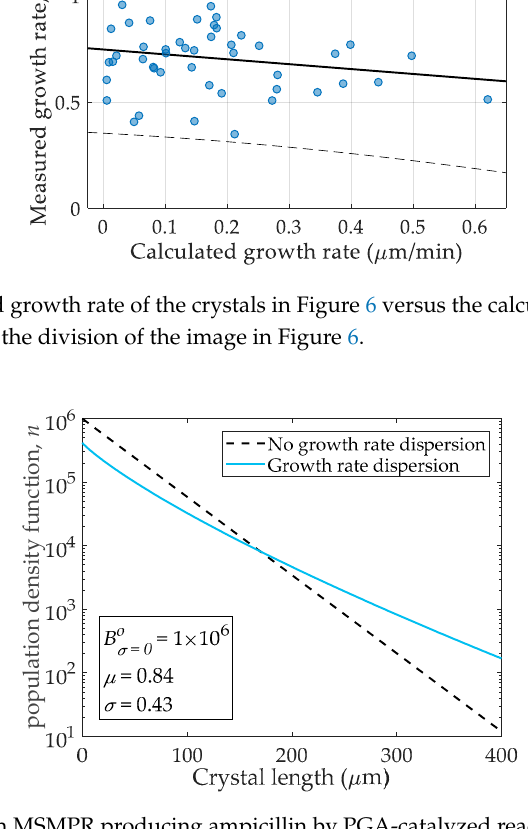
Figure 8. The CSD in an MSMPR producing ampicillin by PGA-catalyzed reactive crystallization. The dashed curve represents the case with no GRD and the solid blue curve shows the CSD when the growth rates follow a normal distribution as described in Figure 2b.